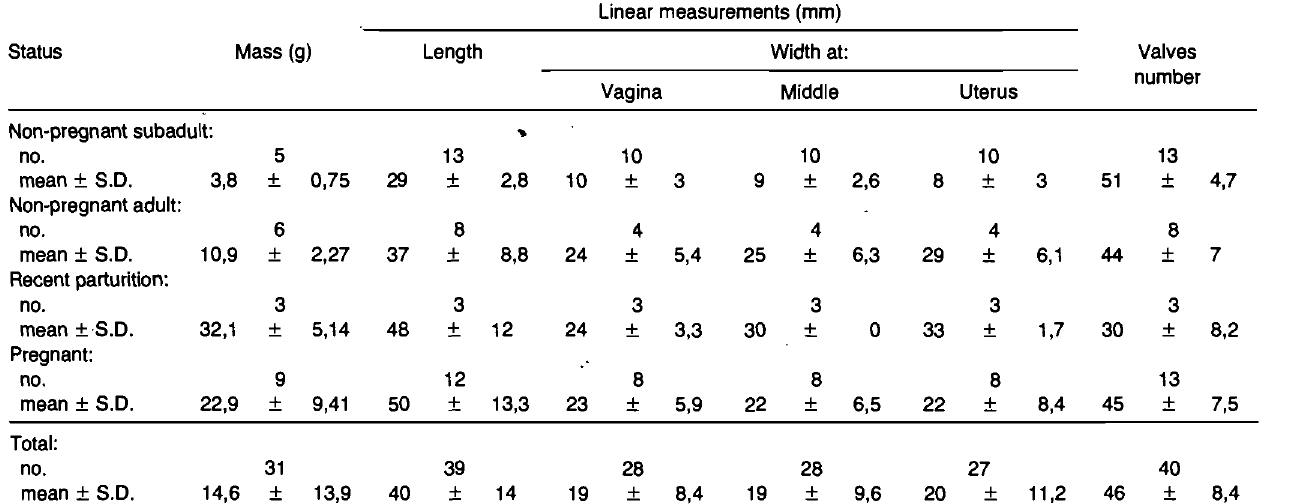
Table 1: MEASUREMENTS OF THE SPRINGBOK CERVIX Linear measurements